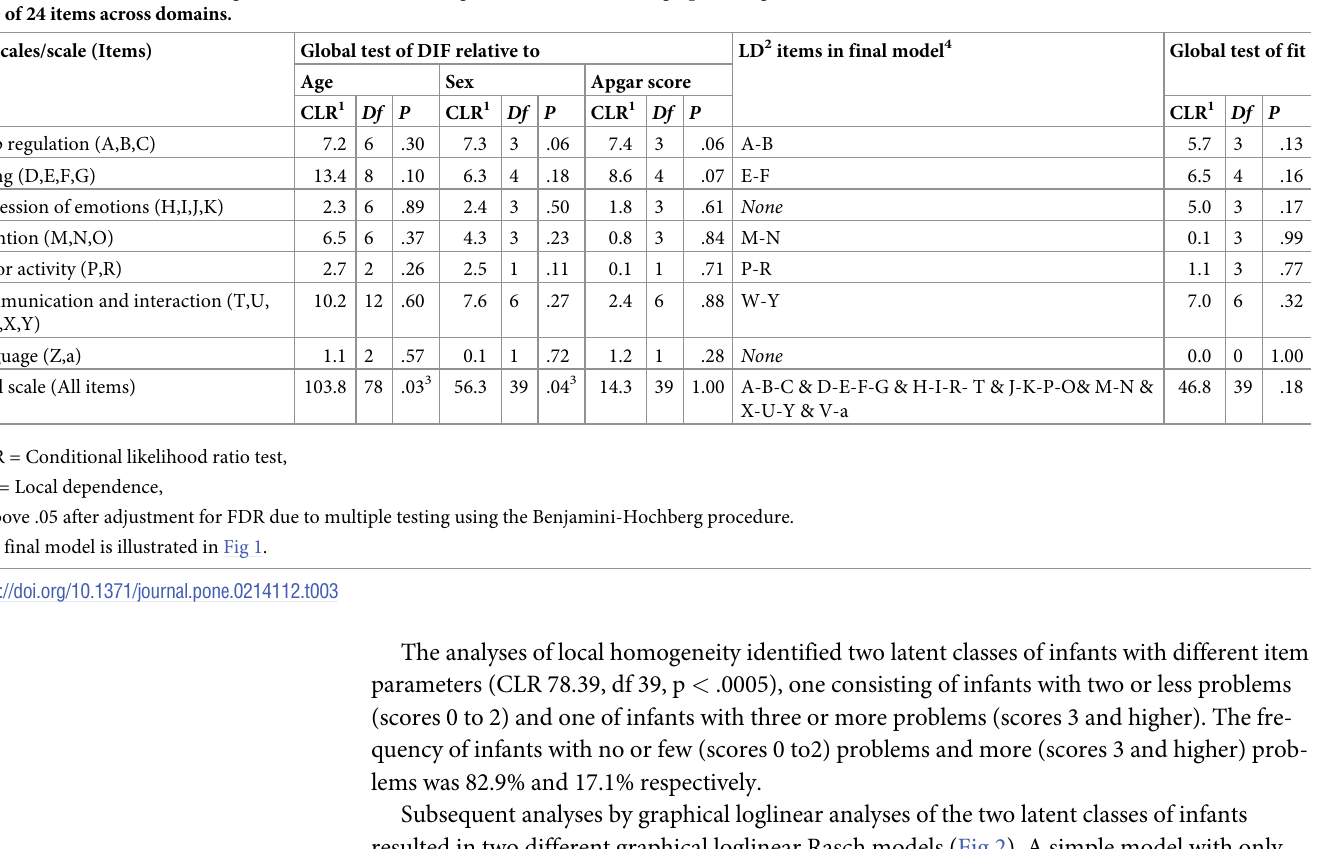
The analyses of local homogeneity identified two latent classes of infants with different item parameters (CLR 78.39, df 39, p < .0005), one consisting of infants with two or less problems (scores 0 to 2) and one of infants with three or more problems (scores 3 and higher). The fre- quency of infants with no or few (scores 0 to2) problems and more (scores 3 and higher) prob- lems was 82.9% and 17.1% respectively.